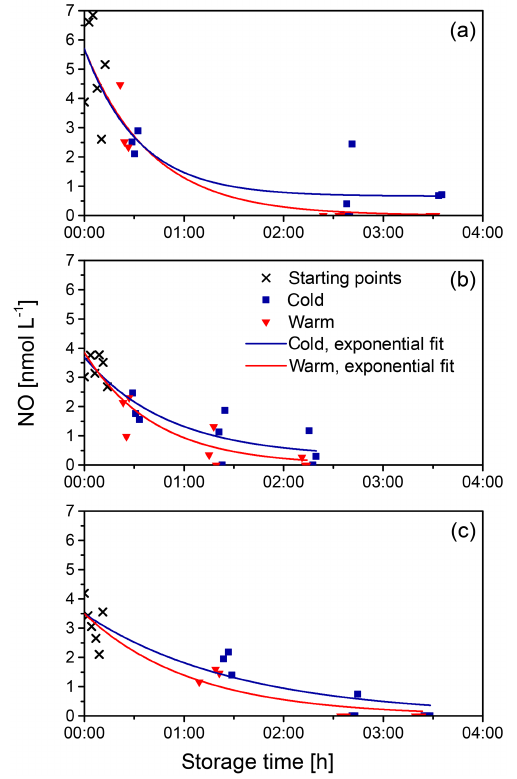
Figure 3. Degradation curves of three sample storage tests. The samples were kept in the dark at room temperature ( ∼ 24 ◦ C, red triangles) and at 6 ◦ C (blue squares). The measurements from the regular sampling (black crosses) were used as starting points for the curve fitting of both temperature settings. (a–b) M93 station 399-4 at 12.525 ◦ S, 77.597 ◦ W; sampling depth: 77 and 67m respectively. (c) M93 station 391-4 at 12.668 ◦ S, 77.821 ◦ W; sampling depth: 87m.